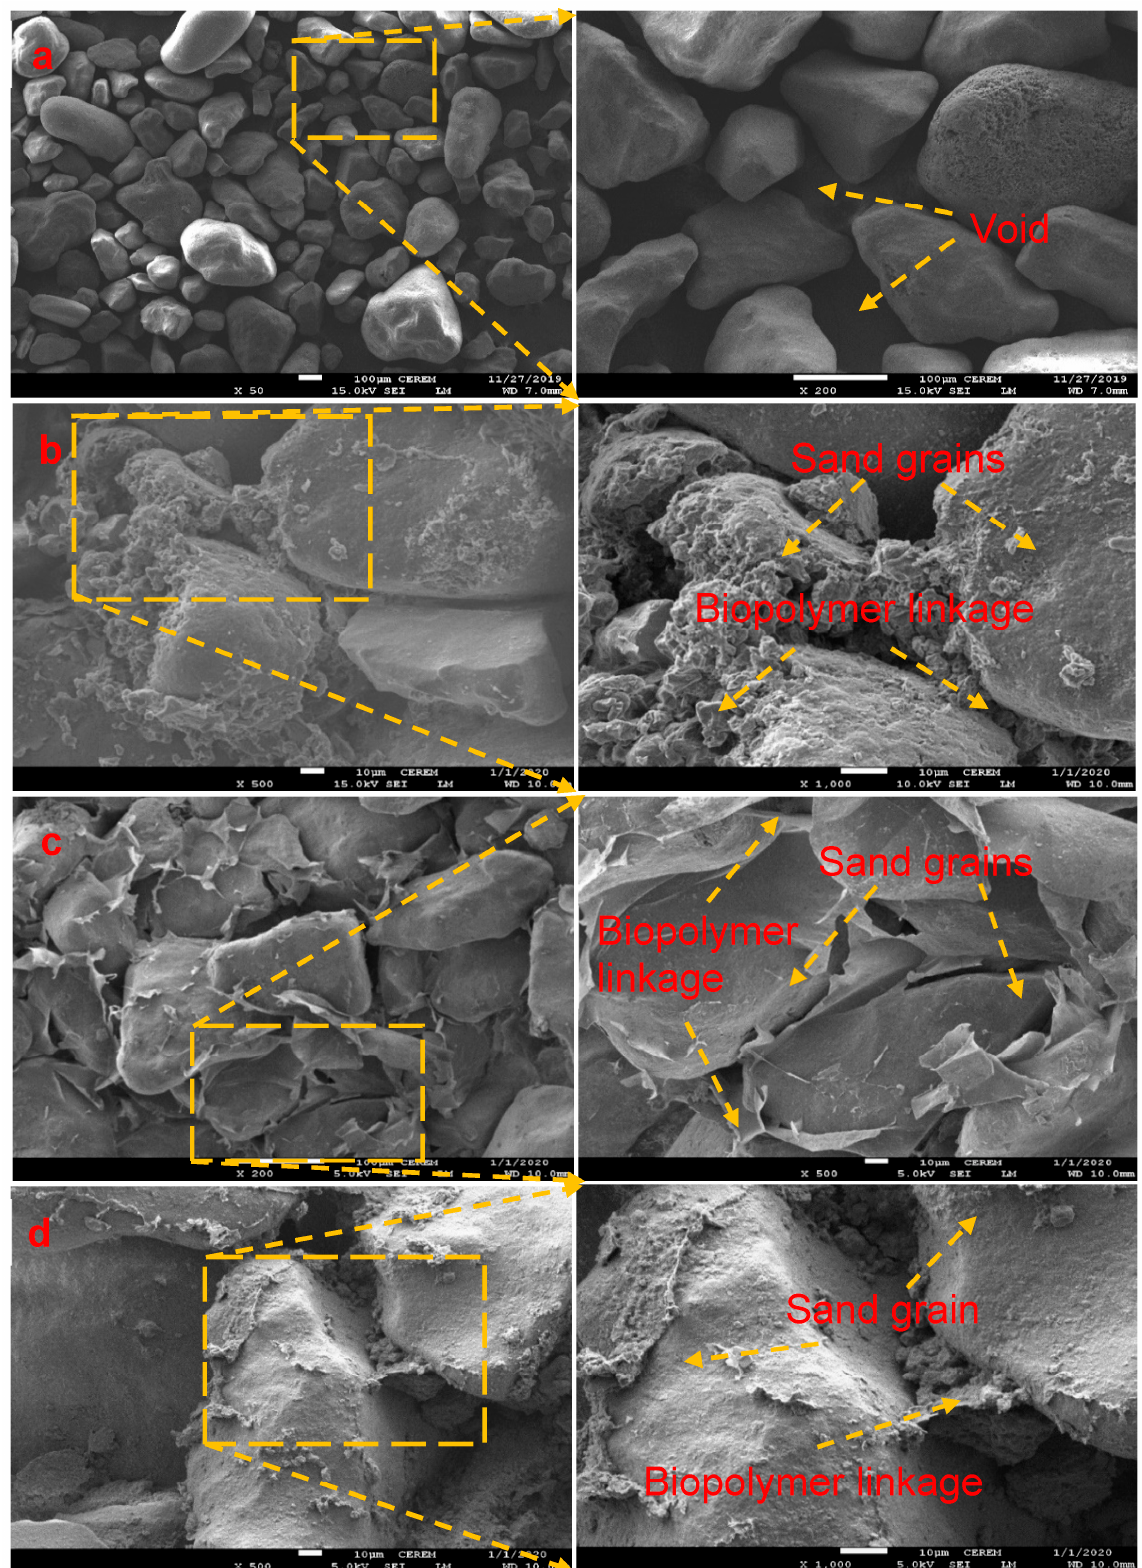
Figure 10. SEM images of ( a ) natural sand; ( b ) 2% Acacia-modified; ( c ) 2% Sodium alginate-modified; ( d ) 2% Pectin ‐ modified.